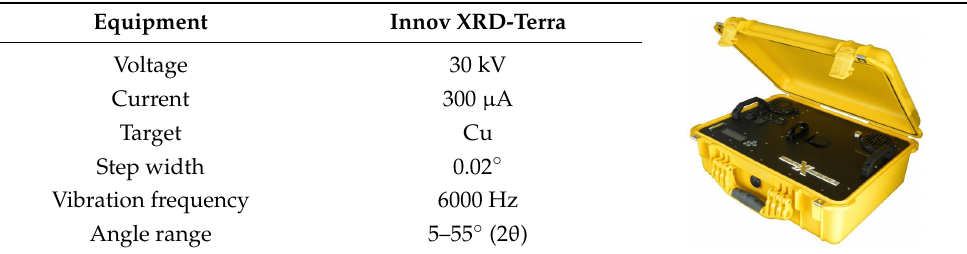
Table 4. The content of each mineral in the samples. Sample No.